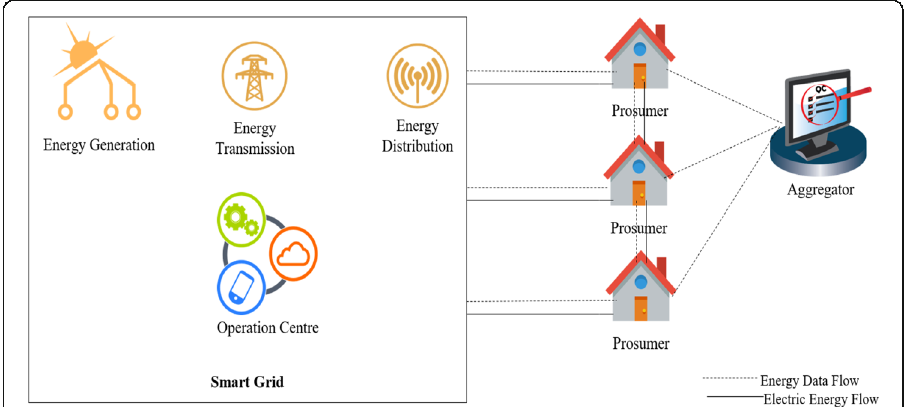
Fig. 2 Overview of smart grid, prosumers, and